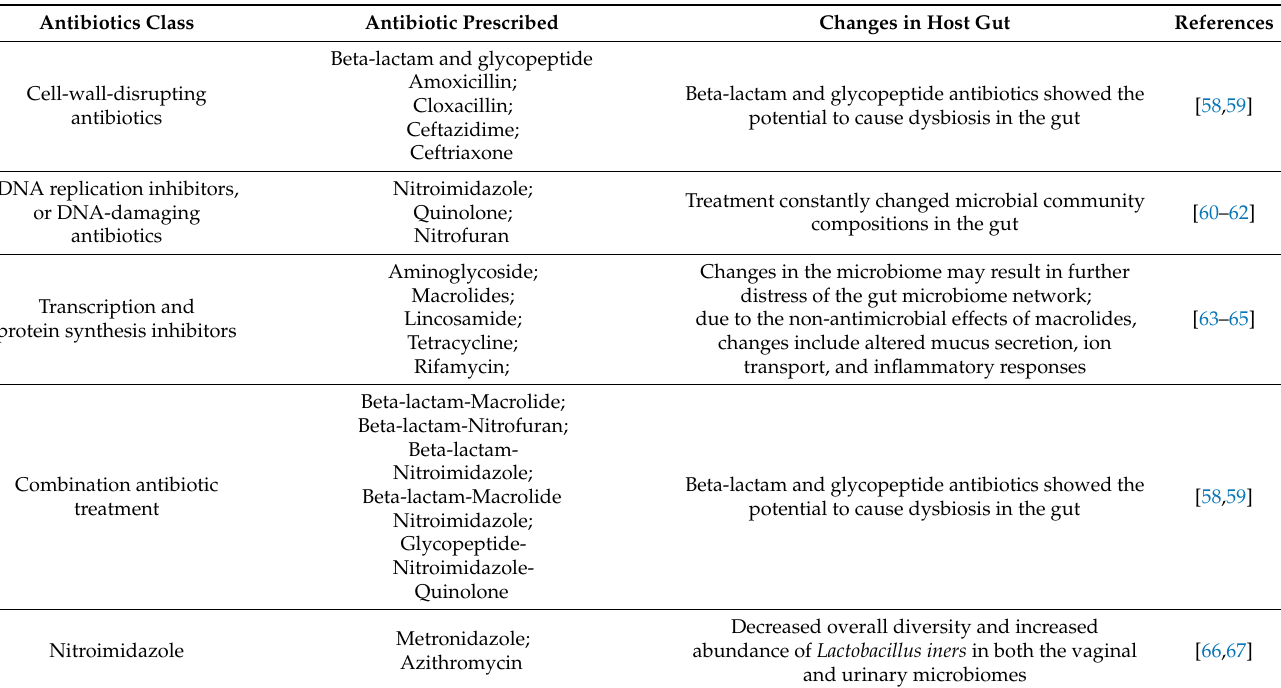
Table 2. Antibiotics studied for changes in the condition of gut